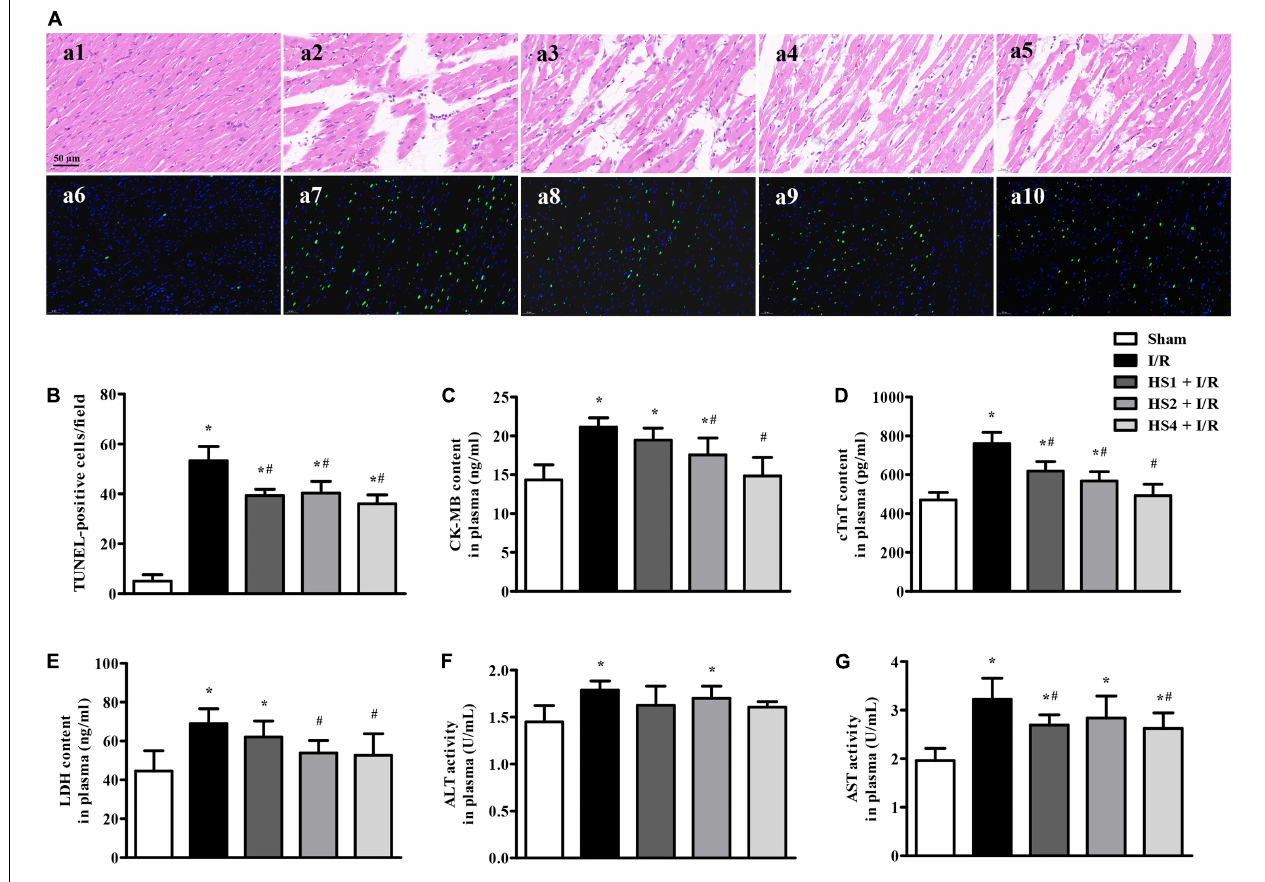
FIGURE 4 | Effect of Herba Siegesbeckiae (HS) on myocardial histology, apoptosis, and injury after Ischemia/Reperfusion (I/R). (A) Representative HE-stained (a1–a5) and TUNEL staining (a6–a10) photographs in Sham (a1,a6), I/R (a2,a7), HS1 + I/R (a3,a8), HS2 + I/R (a4,a9), and HS4 + I/R (a5,a10) groups. Bar = 50 µ m. (B) The quantitative analysis of TUNEL-positive cells/field in different groups ( n = 3). (C–G) The plasma contents of CK-MB (C) , cTnT (D) , LDH (E) , and activities of ALT (F) and AST (G) in different groups ( n = 9). ∗ P < 0.05 vs. Sham group, # P < 0.05 vs. I/R